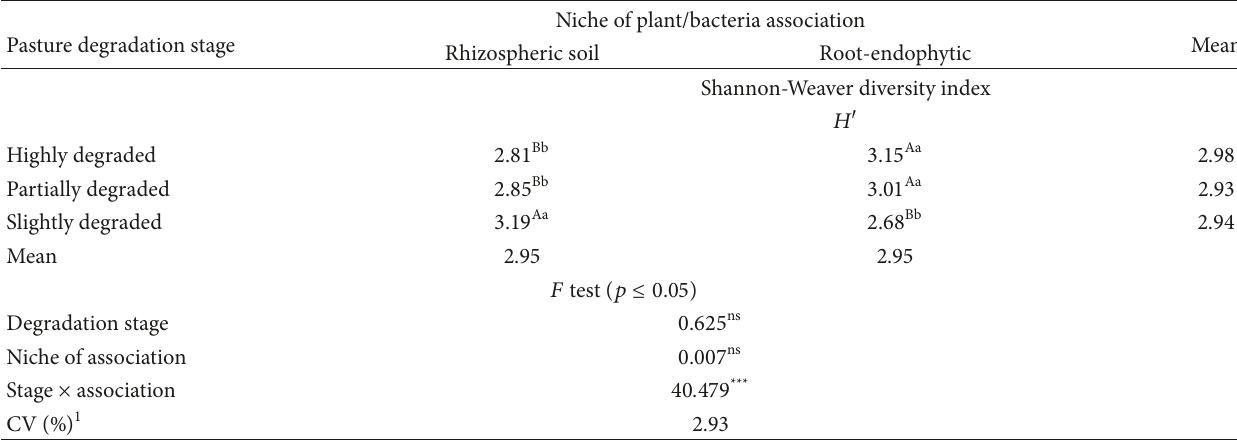
Table 6: Shannon-Weaver diversity index of the total diazotrophic bacterial community in different niches of plant/bacteria association in B. decumbens Stapf. pasture in different stages of